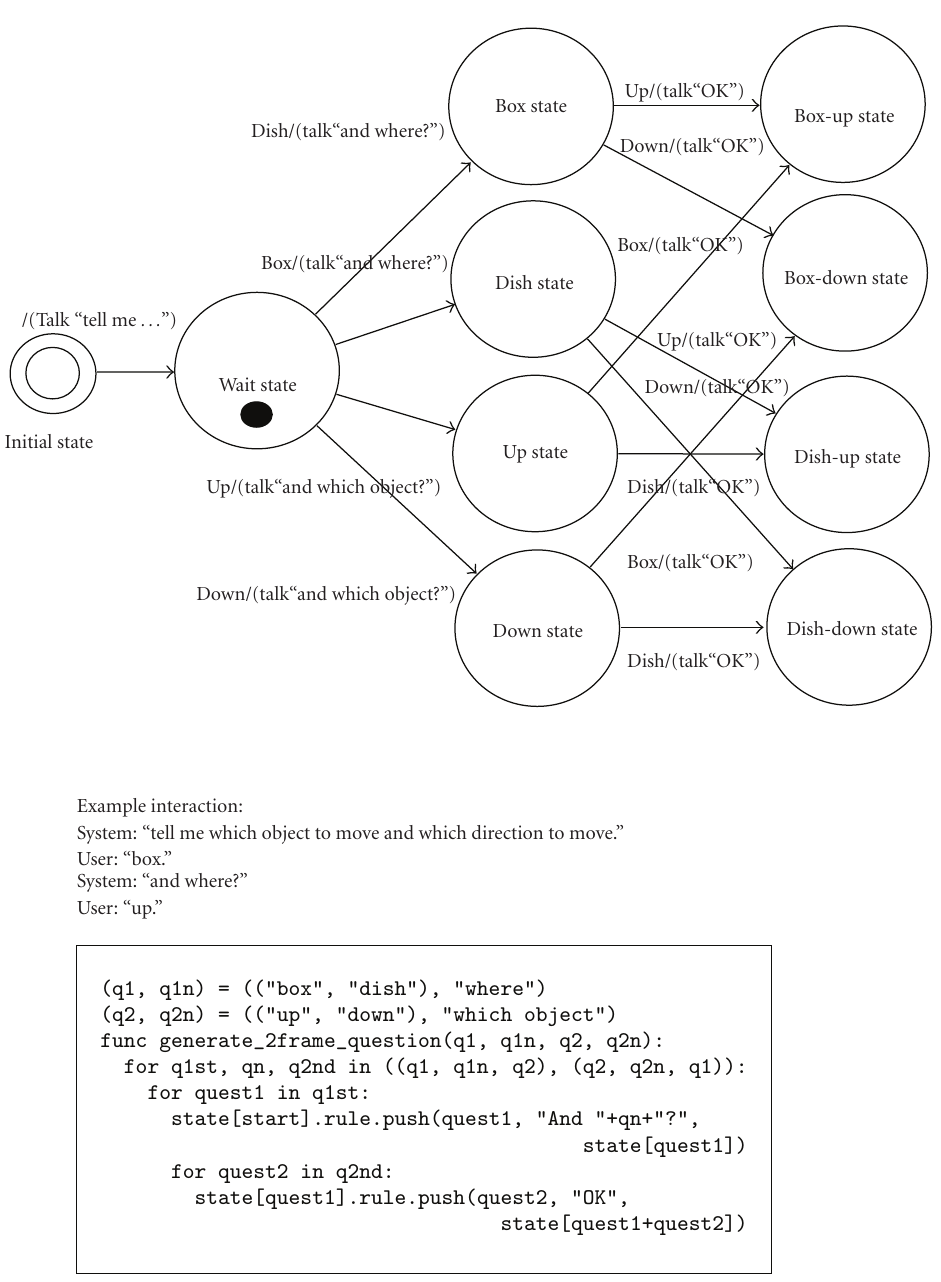
Figure 3: Example of state-transition model that can realize a 2-frame question. The structure of the model looks complex, but it can be generated easily using a simple